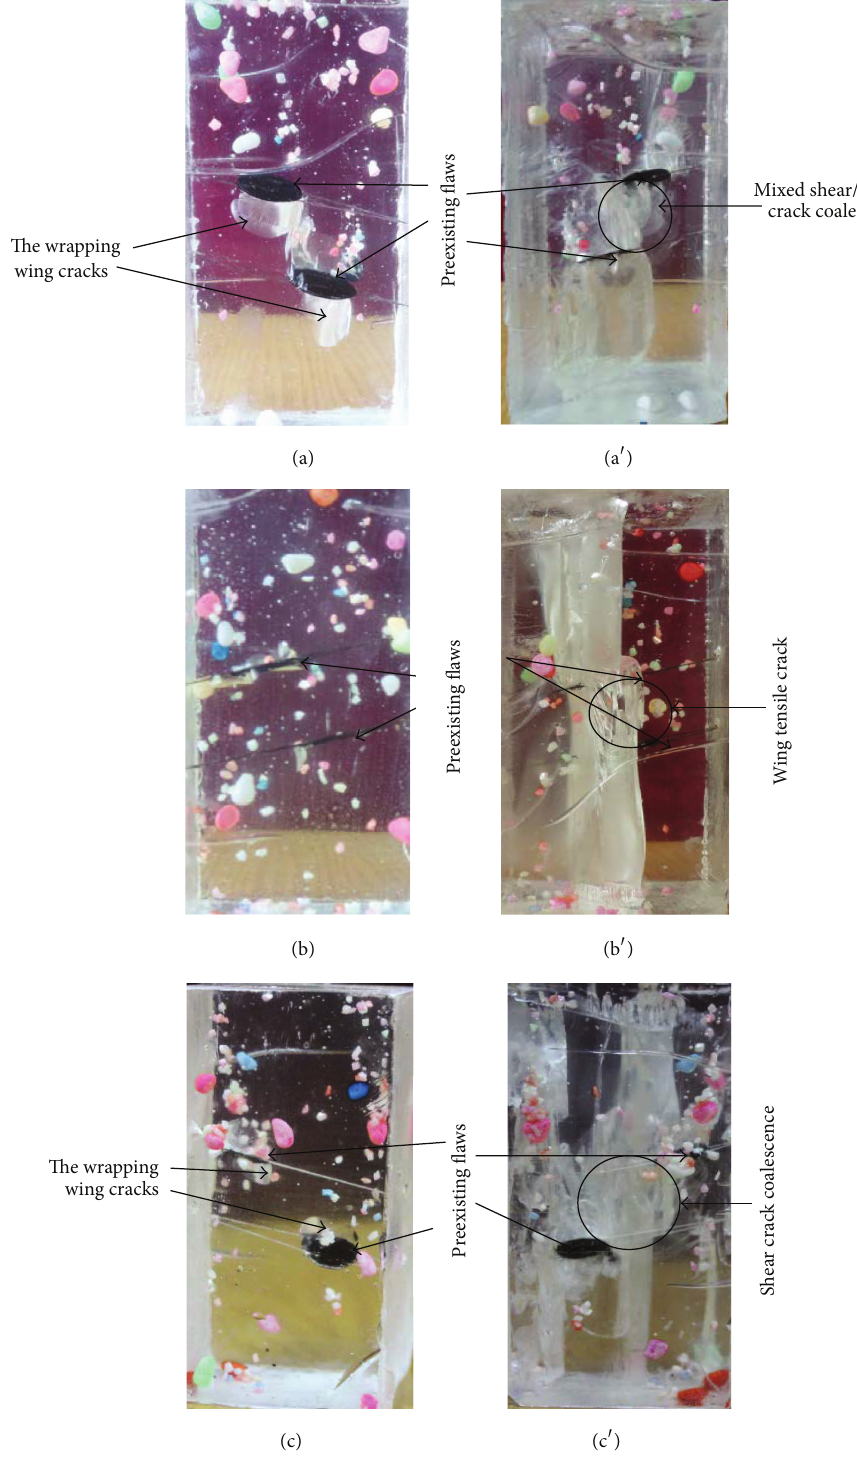
Figure 4: Modes of crack coalescence with different rock bridge angles: the inclination angle is about 30 ∘ ; the frictional coefficient 𝜇 is about 0.577. (a) Showing the early stage of crack coalescence process under uniaxial compression when rock bridge angle is 85 ∘ , (a 󸀠 ) showing the failure of the specimen under uniaxial compression when rock bridge angle is 85 ∘ ; (b) showing the early stage of crack coalescence process under uniaxial compression when rock bridge angle is 110 ∘ , (b 󸀠 ) showing the failure of the specimen under uniaxial compression when rock bridge angle is 110 ∘ ; (c) showing the early stage of crack coalescence process under uniaxial compression when rock bridge angle is 60 ∘ , (c 󸀠 ) showing the failure of the specimen under uniaxial compression when rock bridge angle is 60 ∘